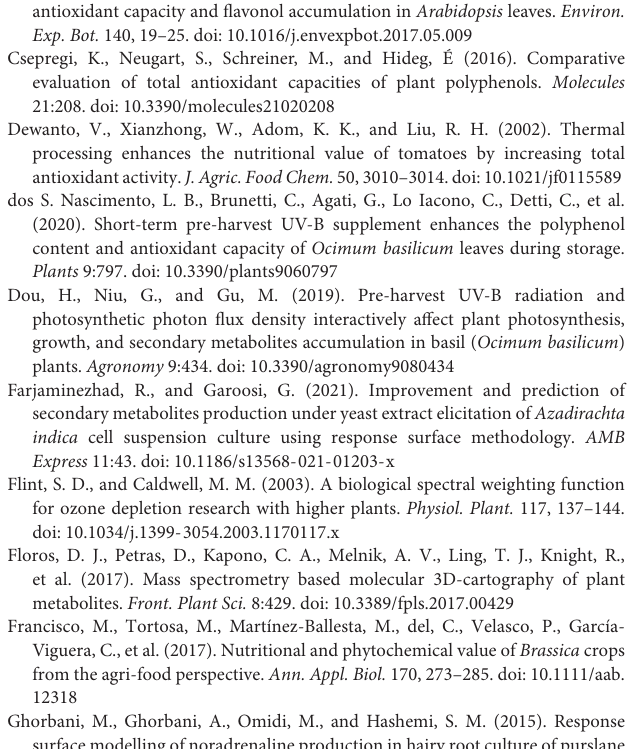
Supplementary Figure 1 | Total fresh mass, leaf area, and root dry mass of kale plants. Supplementary Figure 2 | Leaf fresh mass and leaf area of kale plants. Supplementary Figure 3 | Leaf relative growth rate and expansion rate of leaf populations. Supplementary Figure 4 | Chlorophyll and carotenoid contents in individual leaves of kale plants. Supplementary Figure 5 | Comparison between measured and estimated phenolic contents per leaf of kale plants in the data set. Supplementary Table 1 | Relative growth rate and expansion rate of leaf groups, and the assigned leaf order in kale plants at 23, 30, and 38